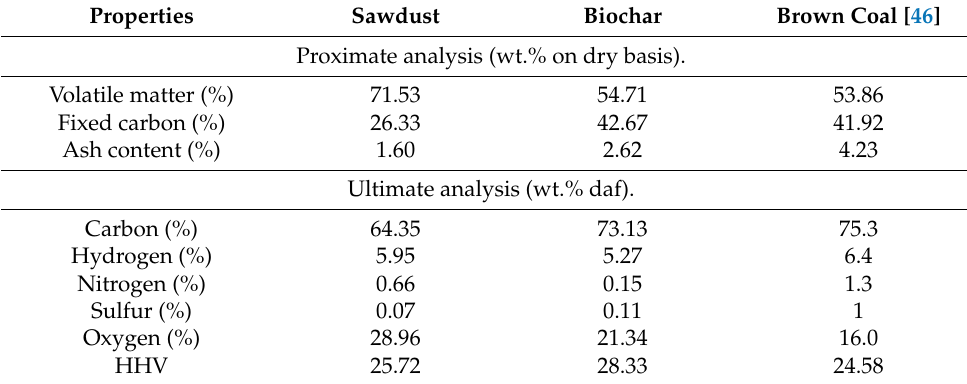
Table 1. Properties of raw sawdust, biochar produced and brown coal.